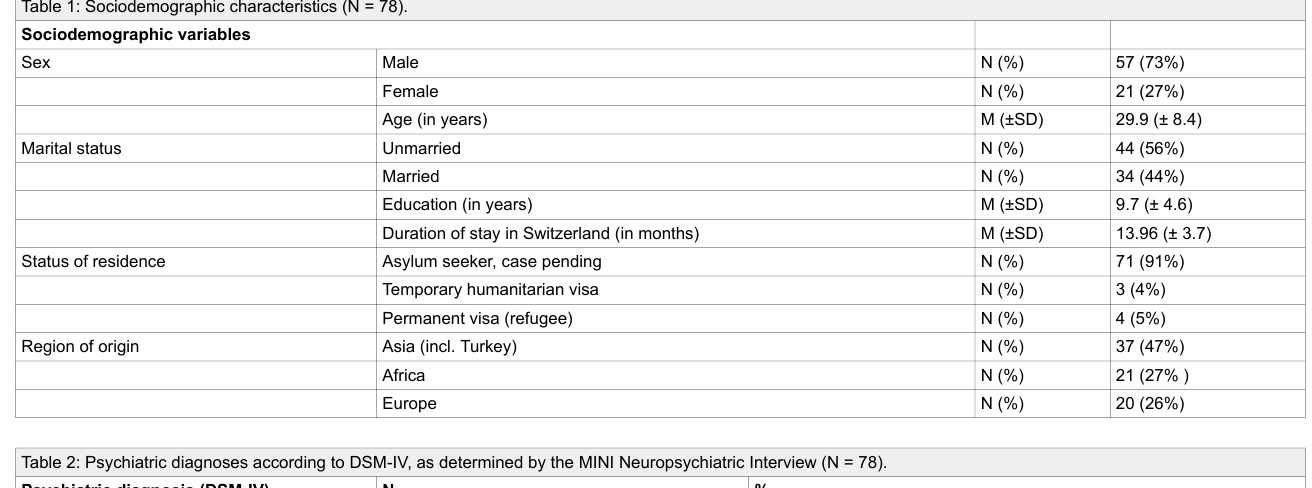
Table 2: Psychiatric diagnoses according to DSM-IV, as determined by the MINI Neuropsychiatric Interview (N = 78). Psychiatric diagnosis (DSM-IV) N % Major depression (MD)